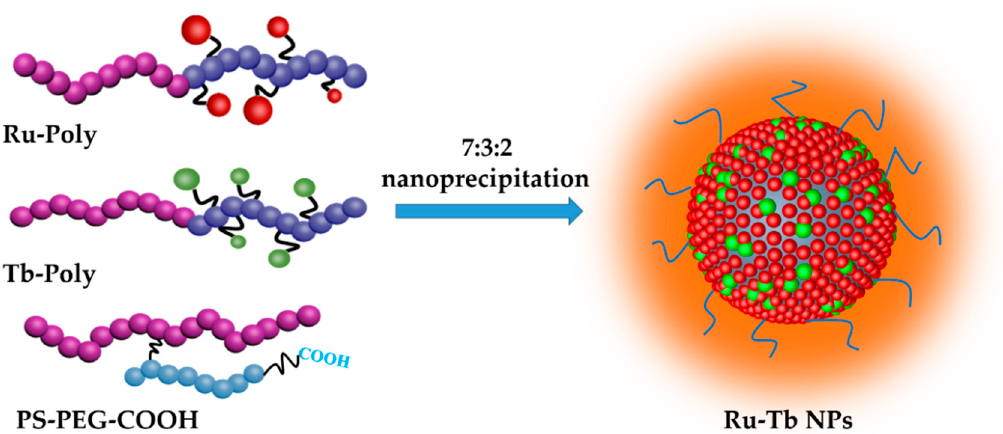
Figure 2. Schematic illustration of the preparation of Ru-Tb NPs.